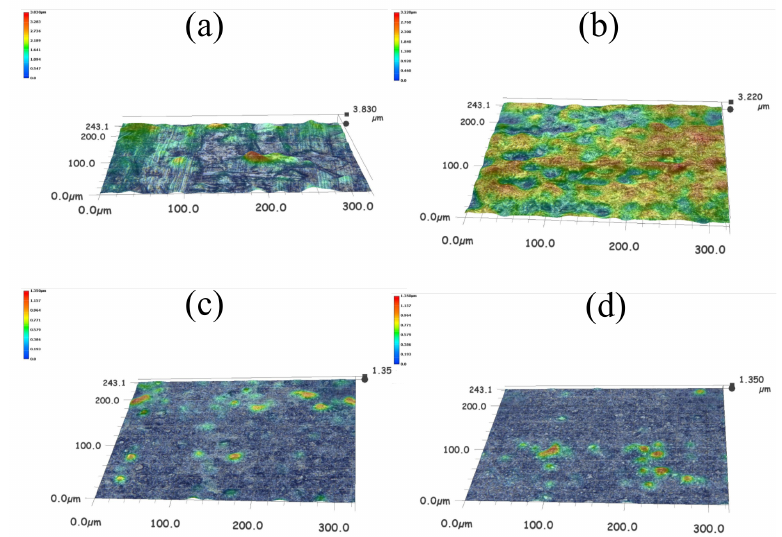
Figure 5. 3D topography of aluminum alloy after laser cleaning at di ff erent speeds: ( a ) Reference sample; ( b ) 10.4 mm / s; ( c ) 4.1 mm / s; ( d ) 1.0 mm /